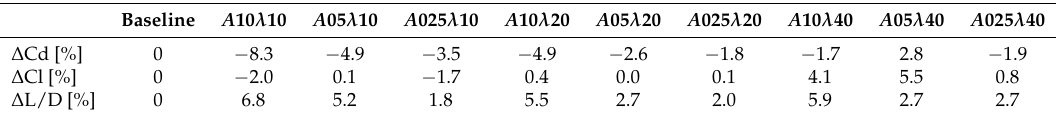
Table 7. Percentage variation of lift, drag and efficiency of the modified geometries (see Table 4) with respect to the baseline configuration.